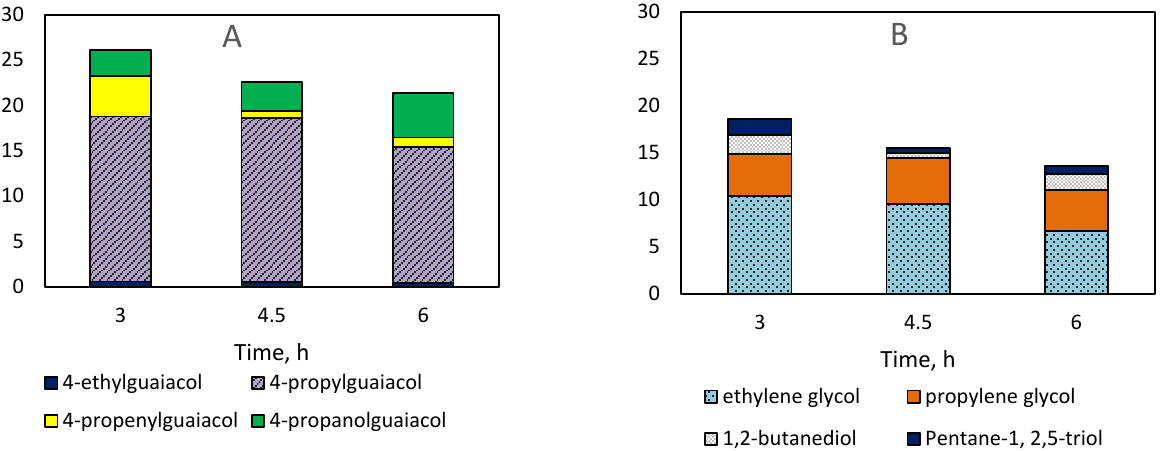
Figure 10. The effect of time of spruce wood RCF on the yield of phenolic monomers ( A ) and polyols ( B ) over the 3RS450 catalyst at 225 °C.